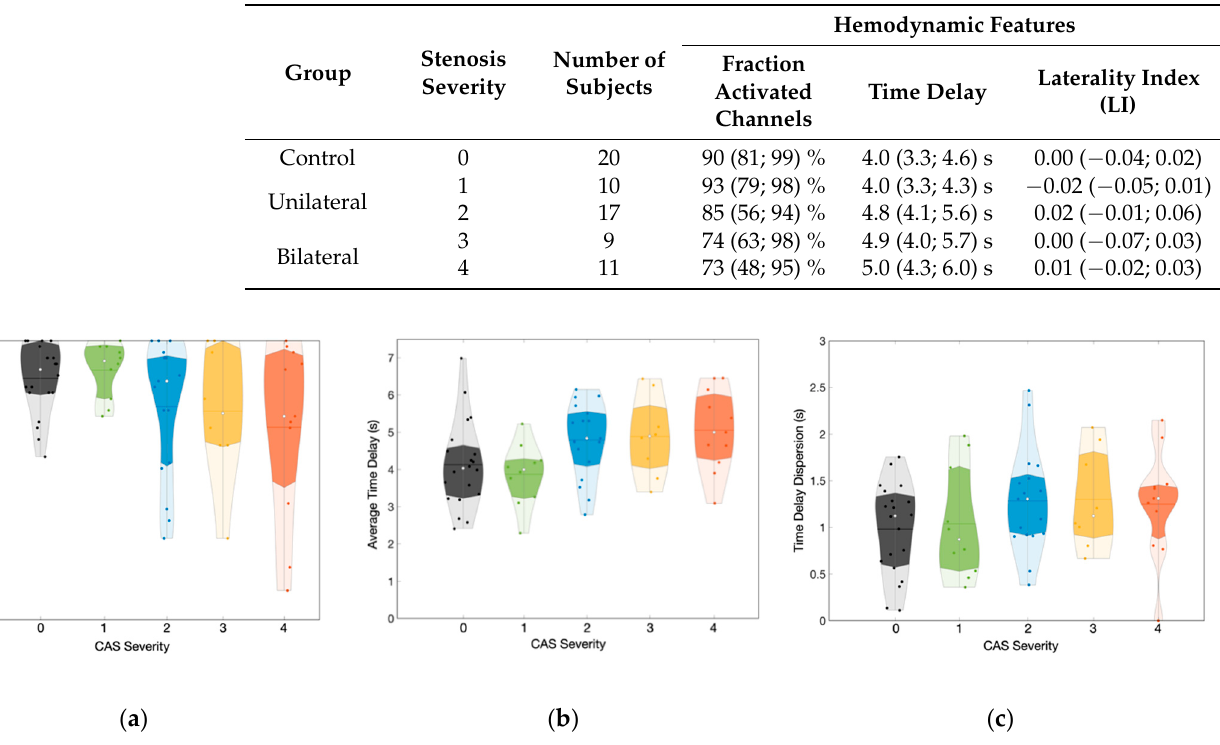
Figure 6. Distribution of the ( a ) fraction of the activated brain channels, ( b ) average time delay across the different brain regions, and ( c ) dispersion of the time delay across the different brain regions as a function of carotid artery stenosis (CAS) severity. Gray: Control, green: unilateral level 1, blue: unilateral level 2, yellow: bilateral level 3 and, orange: bilateral level 4.